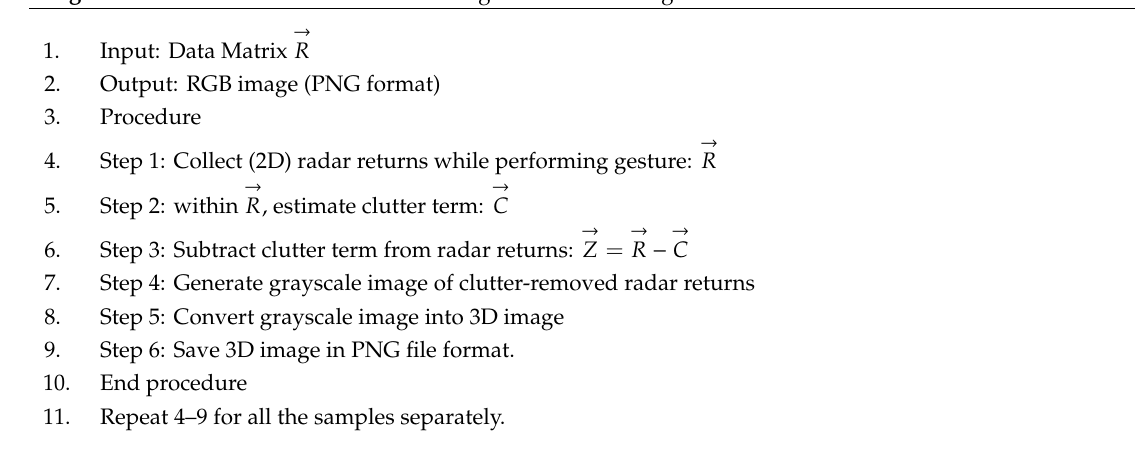
Algorithm 1 Transformation of the Radar Signal into a 3D Image